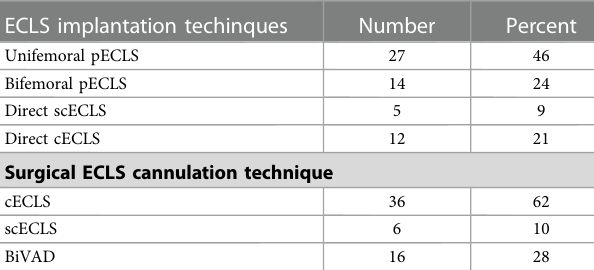
TABLE 2 Baseline patient characteristics. TABLE 3 ECLS implantation